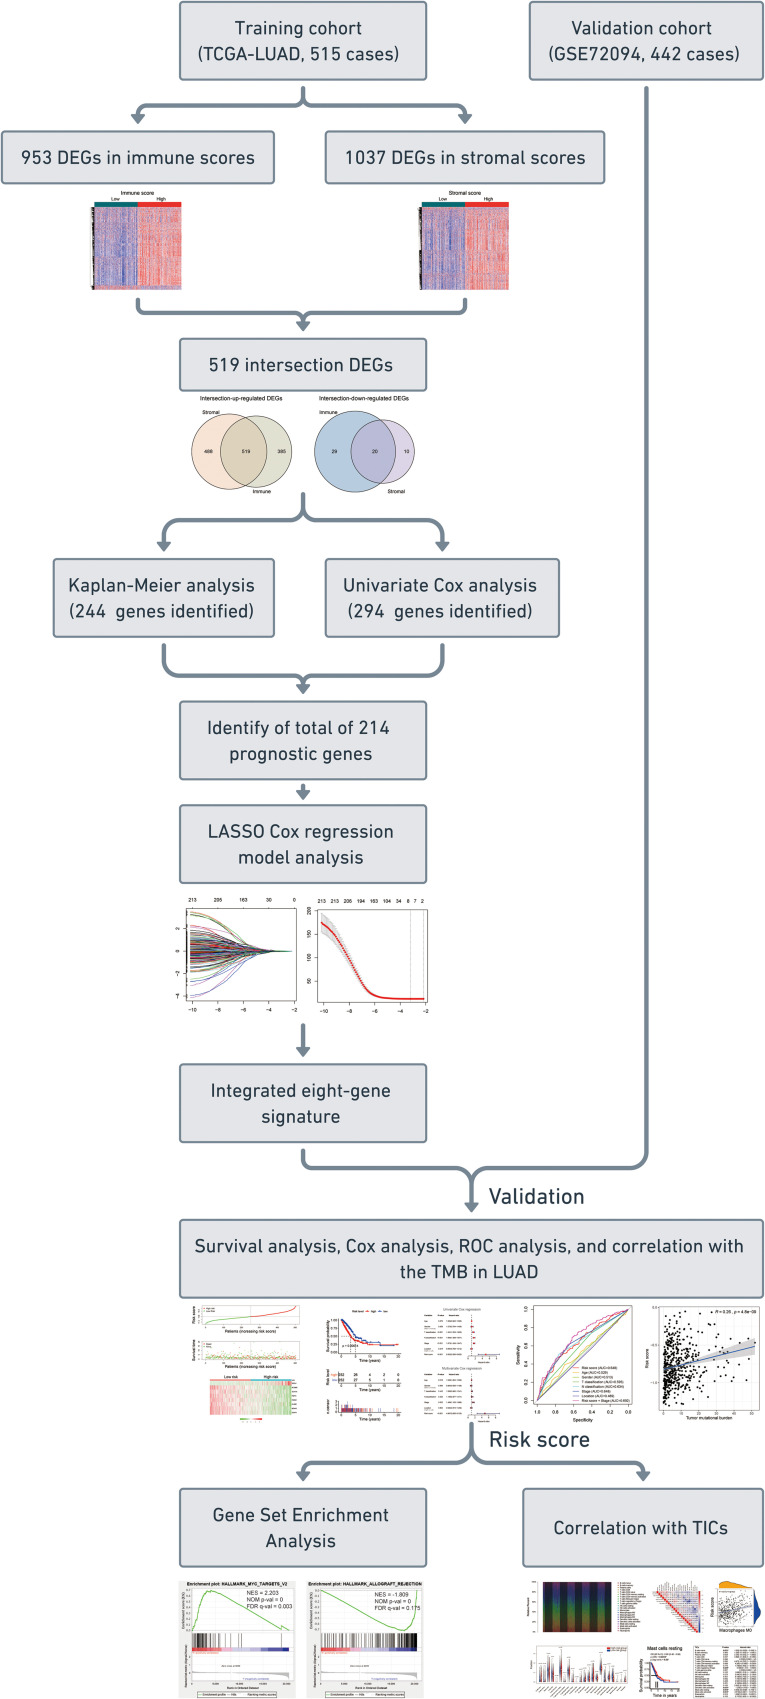
Flow chart of the study. The study was carried out in TCGA-LUAD and GSE72094 cohorts. The training cohort was used to identify prognostic genes. The prognosis analysis was validated in the validation cohort. DEGs, differentially expressed genes; LASSO, the least absolute shrinkage and selection operator Cox regression model; ROC, receiver operating characteristic; TMB, tumor mutational burden; LUAD, lung adenocarcinoma; TICs, tumor-infiltrating immune cells.